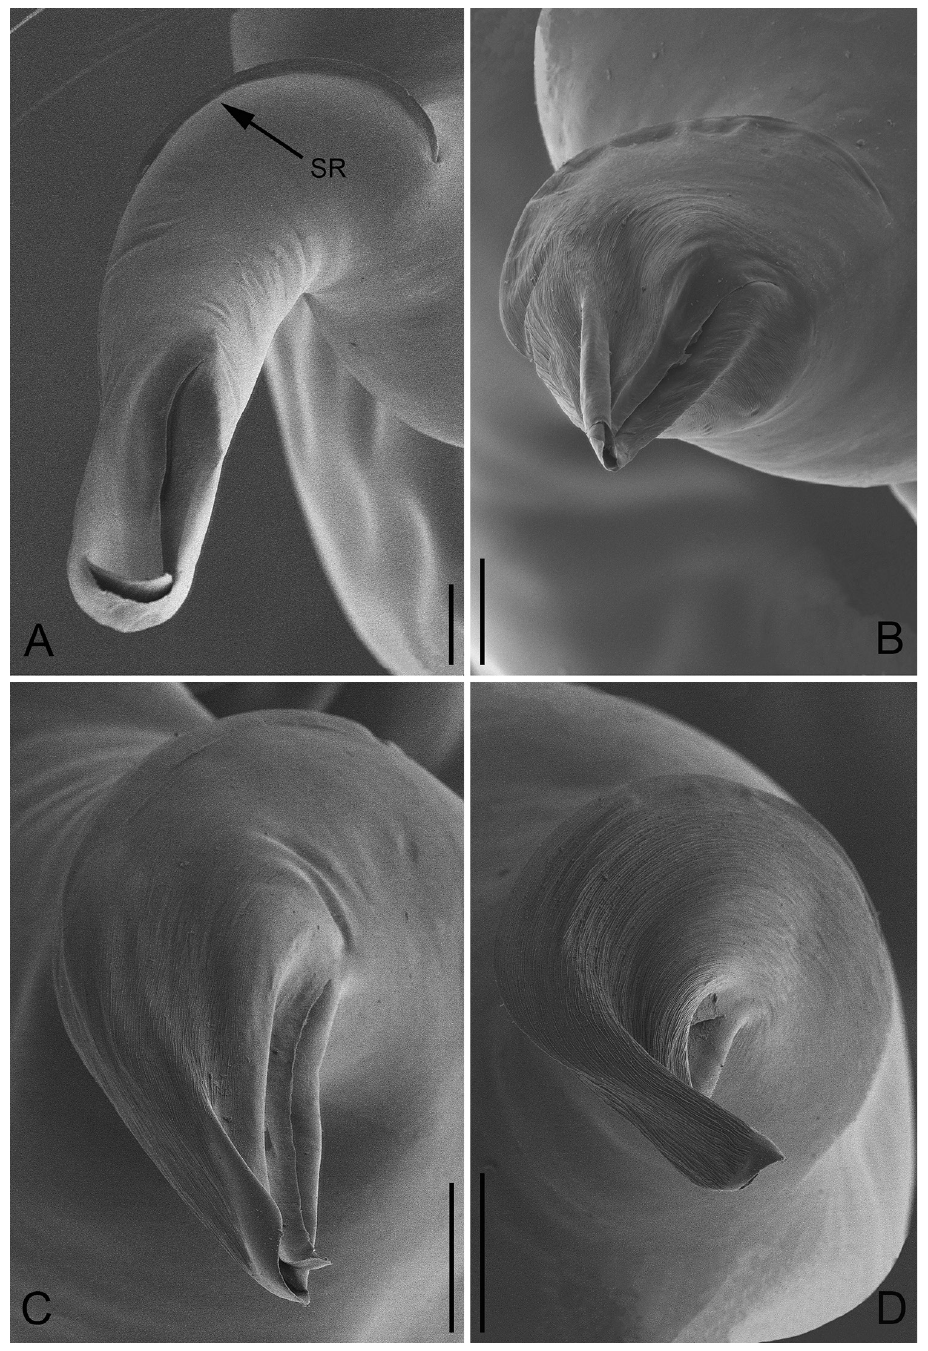
Figure 11. Apical view of embolus of P. bailongensis ( A ); P. cunfengensis sp. n. ( B ); P. podiensis sp. n. ( C ); P. qingfengensis sp. n. ( D ). Scale bars: 0.04